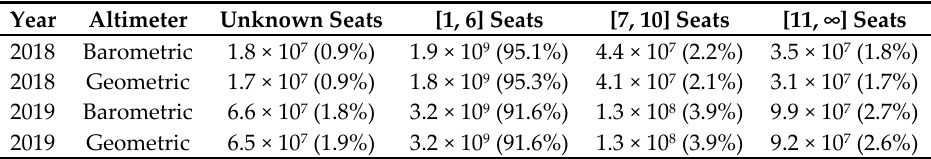
Table 4. Frequency of fixed wing single engine operating at or below 1200 feet AGL.